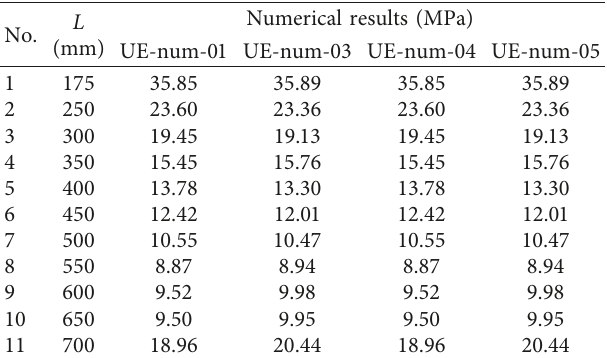
m of different measuring points at different boundary